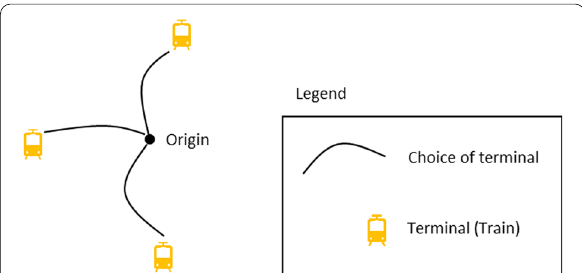
Fig. 2 Schematic figure of stand-alone terminal choice models (Type